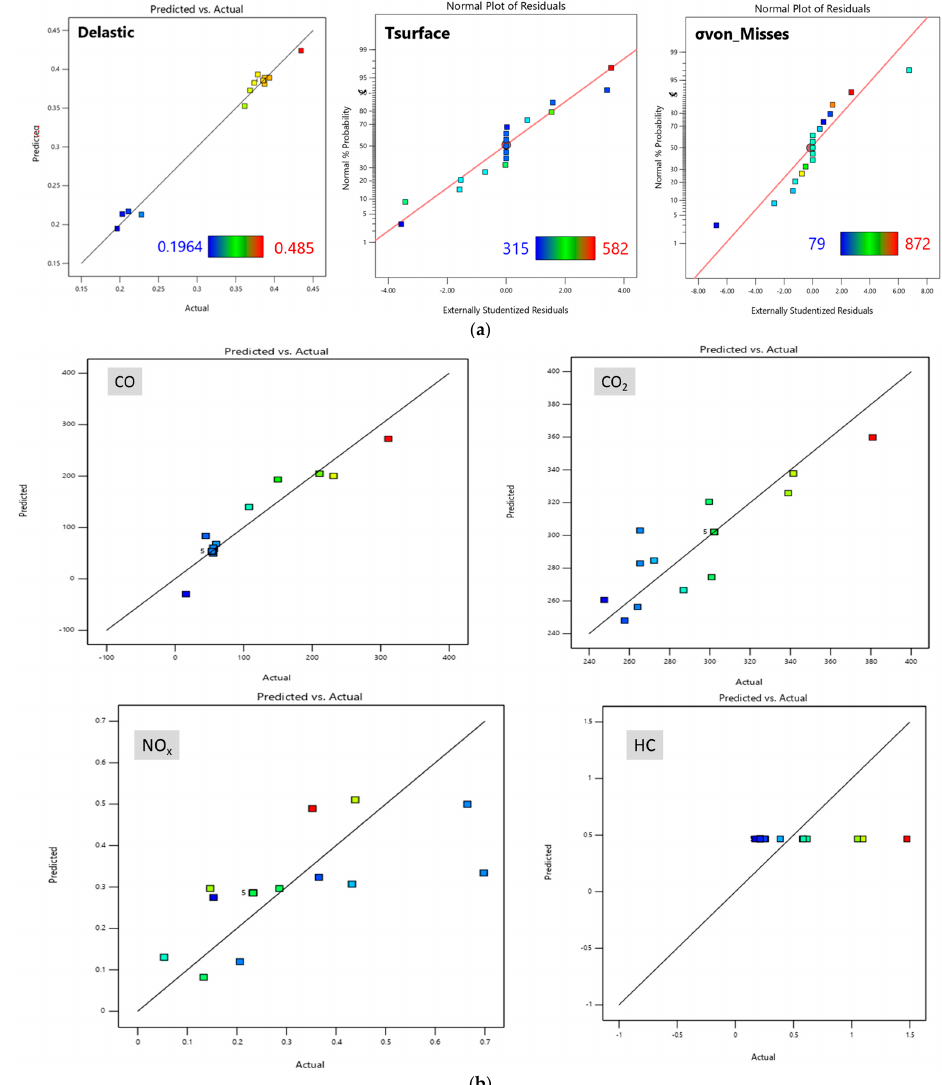
Figure 10. Predicted vs. actual value of output parameters:( a ) elastic response, ( b ) emission response. The effects of the input process variable on the different output parameter can be seen. It can be observed that E has substantial effects on all output parameters among all reaction parameters. Figure 11a,b show the Box–Cox plot of elastic response and emission response, respectively. It transforms the elastic and emission data to close to normal